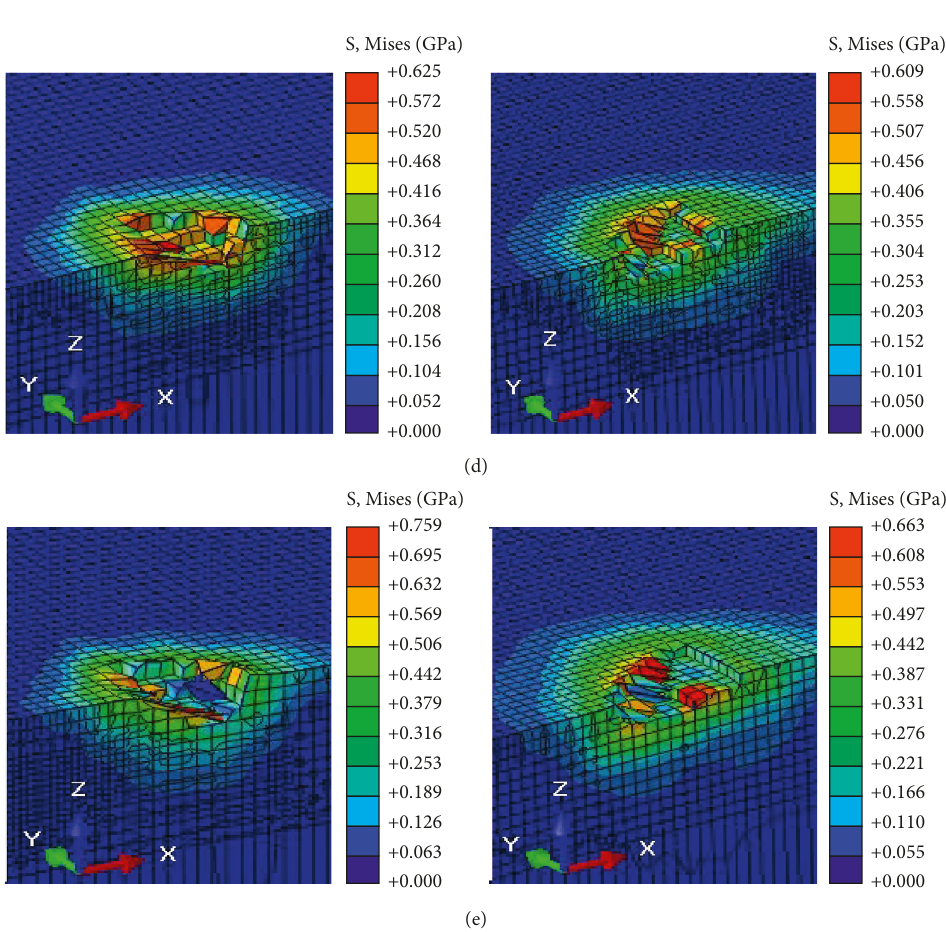
Figure 8: Stress contour of the target at different impact velocities: (a) 10m/s, (b) 12.5m/s, (c) 15m/s, (d) 17.5m/s, and (e) 20 m/s (the left figures are 30 ° and the right figures are 75 °